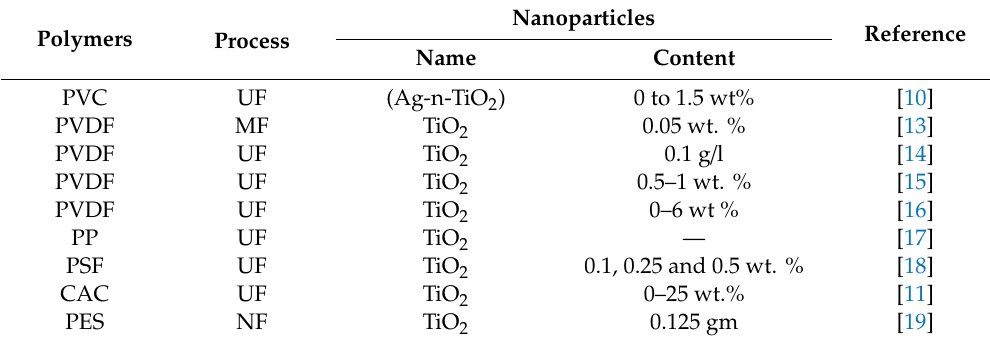
Table 1. Studies have reported the embedded of TiO 2 -NPs with several polymers and cellulose acetate.